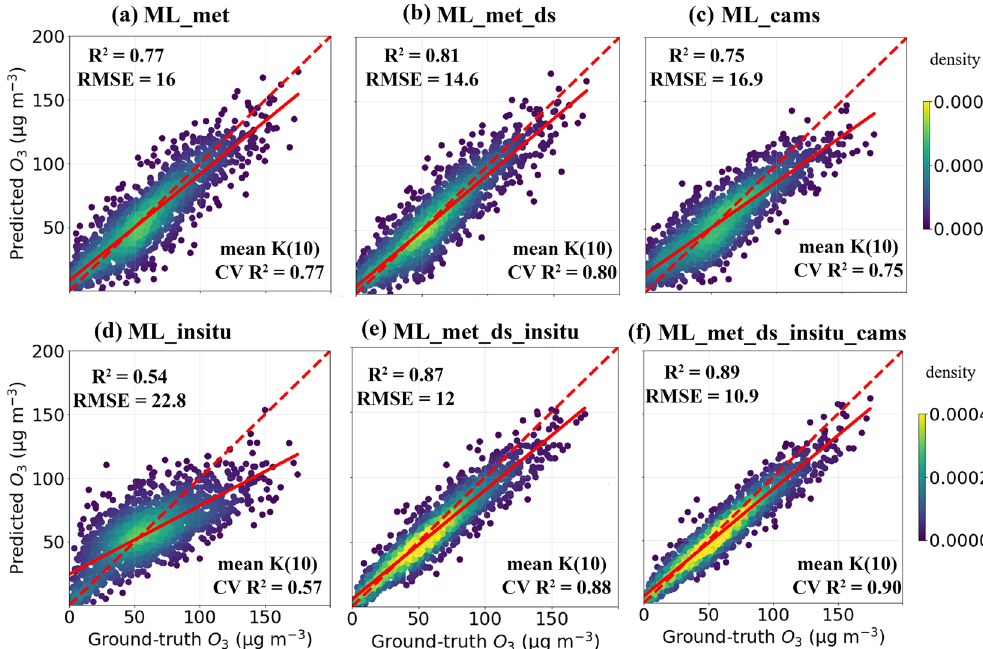
Figure 1. Density scatter plots of predicted ozone by different ML simulation type vs ground-truth ozone at Lothstrasse station at Munich. In a total of 5375 days (between 2001 to 2017), first 3800 days used for training 2 and remaining 1575 days used for testing. Mean R of k(10)-fold cross validation is also given at bottom of figure panels at each case. Red solid line represents the linear fit and red dotted line represents 1:1 line.